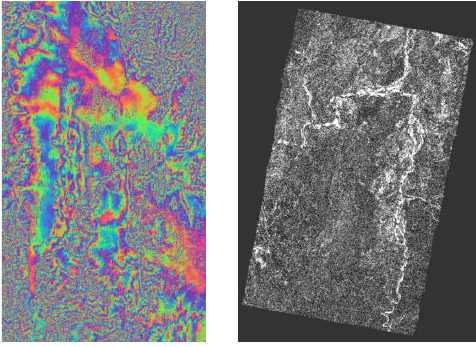
Figure 7. Interferogram and Coherence.